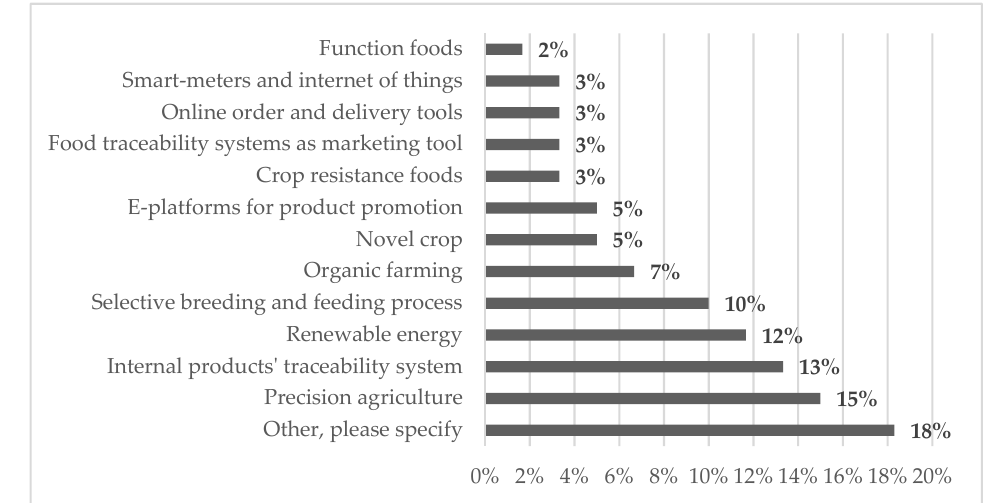
Figure 3. The type of technology adopted by rural SMEs. Source: own processing of survey. In order to identify the factors that may inhibit SMEs in rural areas from innovating in this sector, the chi-square ( χ 2 ) statistic was applied to analyse group differences when the dependent variable was measured at a nominal (categorical) level (Lu et al. 2014). The dependent variables are here classified into three groups: (1) job generation and no job generation, (2) access to new markets and no access to new markets, and (3) firm profitability and no firm profitability. It permits the evaluation of both dichotomous independent variables and of multiple group studies (Preacher